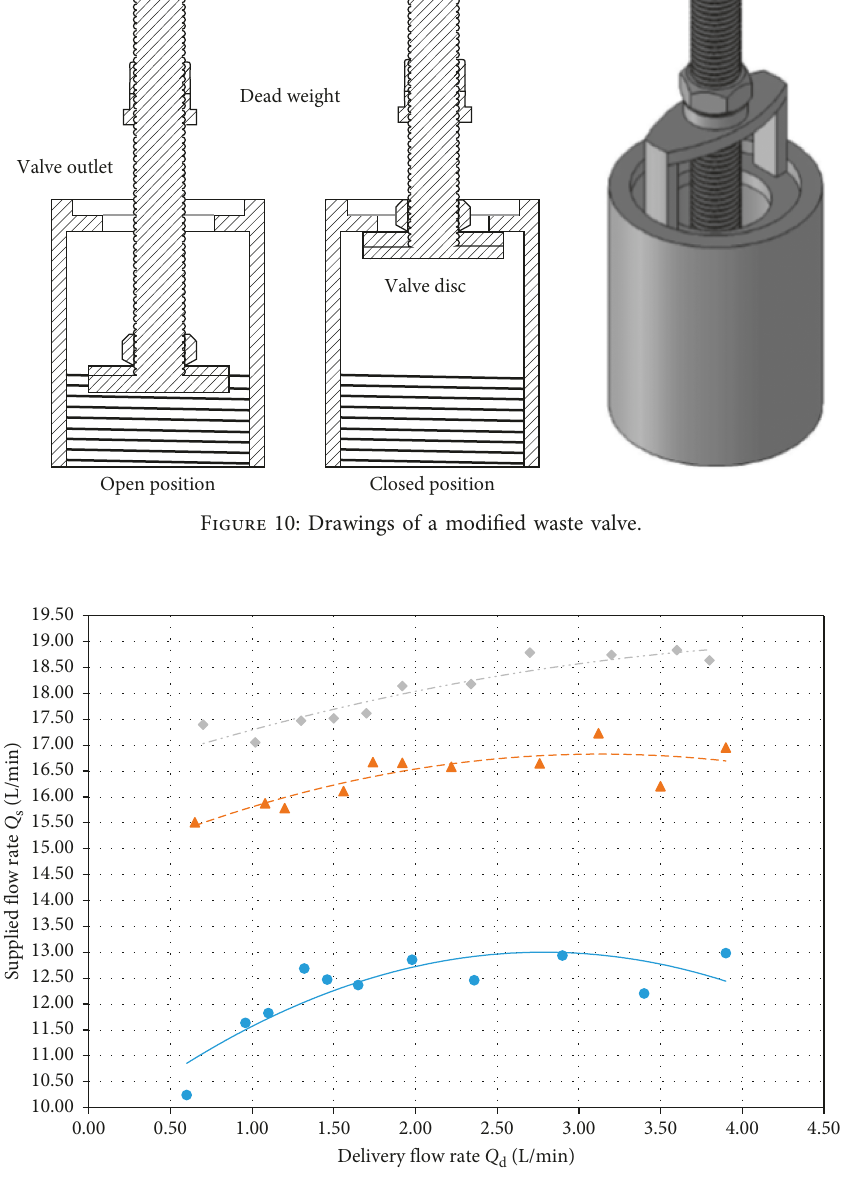
b (cid:31) 208, 244, and